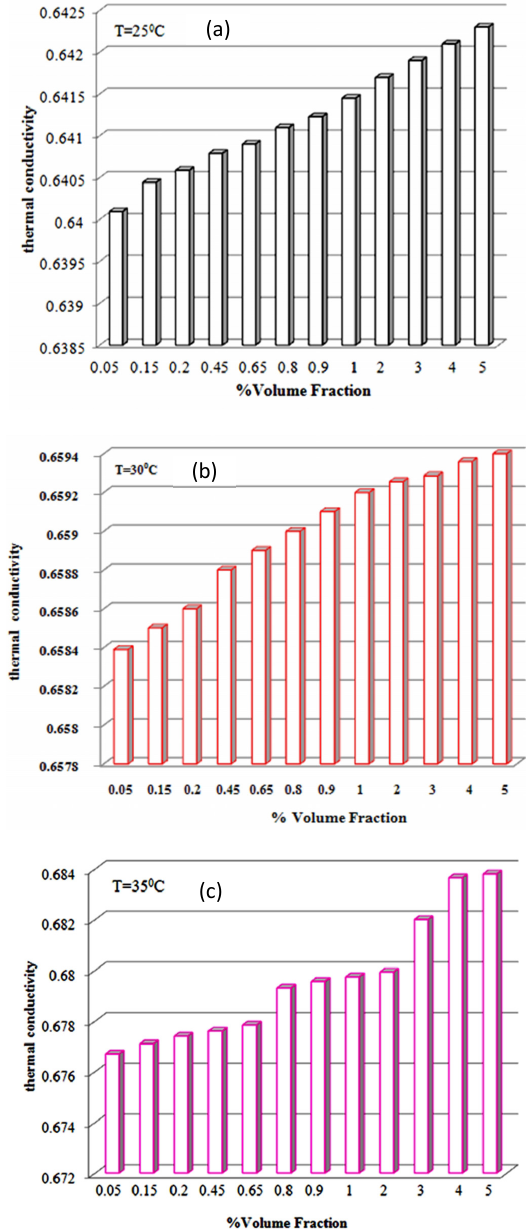
Fig. 4: Thermal conductivity of nanofluid at volume fractions between 0.05-5 at temperatures a) 25, b) 30 and c) 35 o